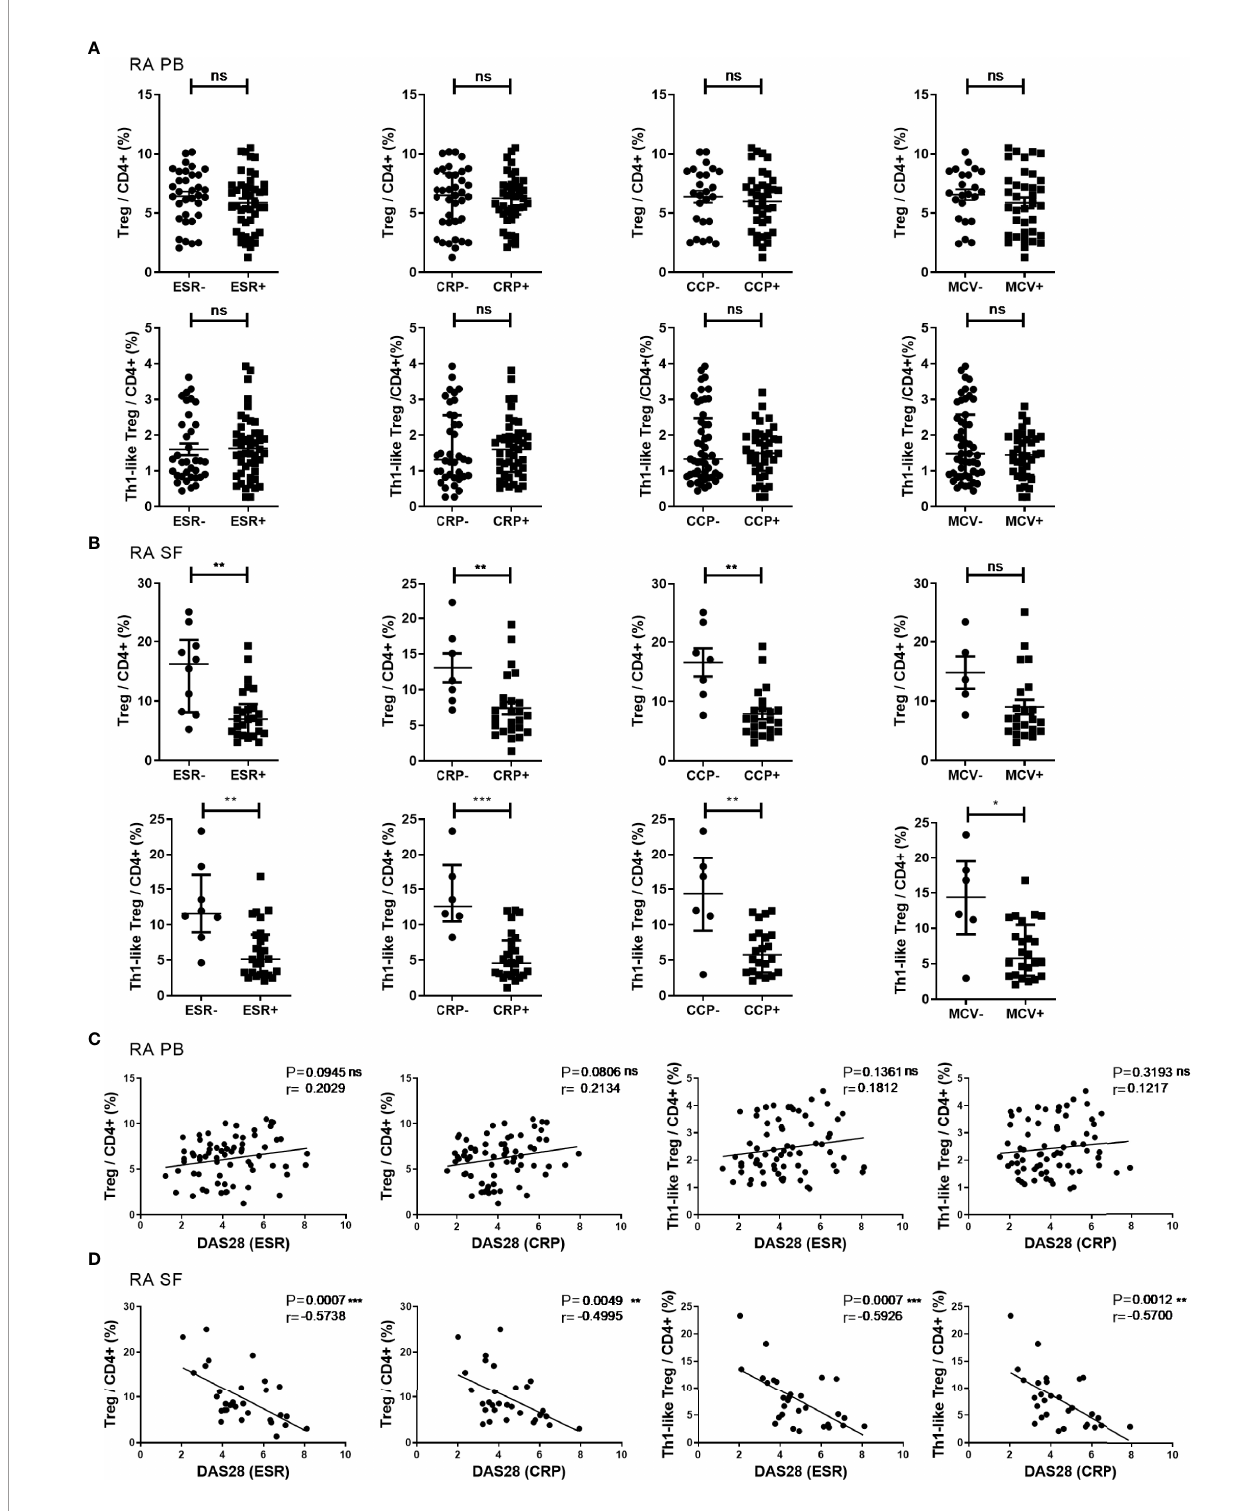
FIGURE 3 | The proportion of Treg cells and their subsets in different disease states and their correlations. (A, B) Comparison of the proportions of Treg cells and Th1-like Treg cells in RA PB (A) and RA SF (B) in subgroups based on clinical indicators. (C, D) Correlation analysis between the proportions of Treg cells or Th1-like Treg cells and DAS28 in RA PB (C) and RA SF (D) . Data are from 78 RA patients and 36 SF samples. * p < 0.05, ** p < 0.01, *** p < 0.001, ns, not statistically signi fi